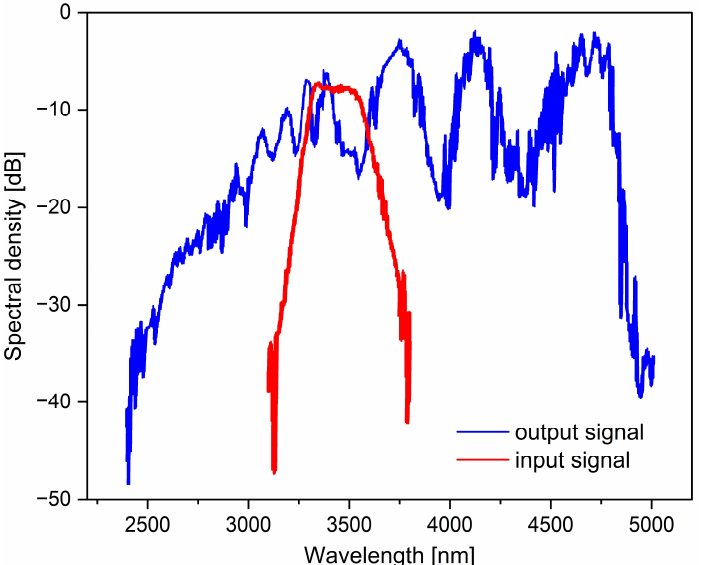
Figure 4. Supercontinuum generation in a 9.5-m-long fluoroindate fiber. Adopted with permission from [101]. Copyright 2013, Optica Publishing Group.